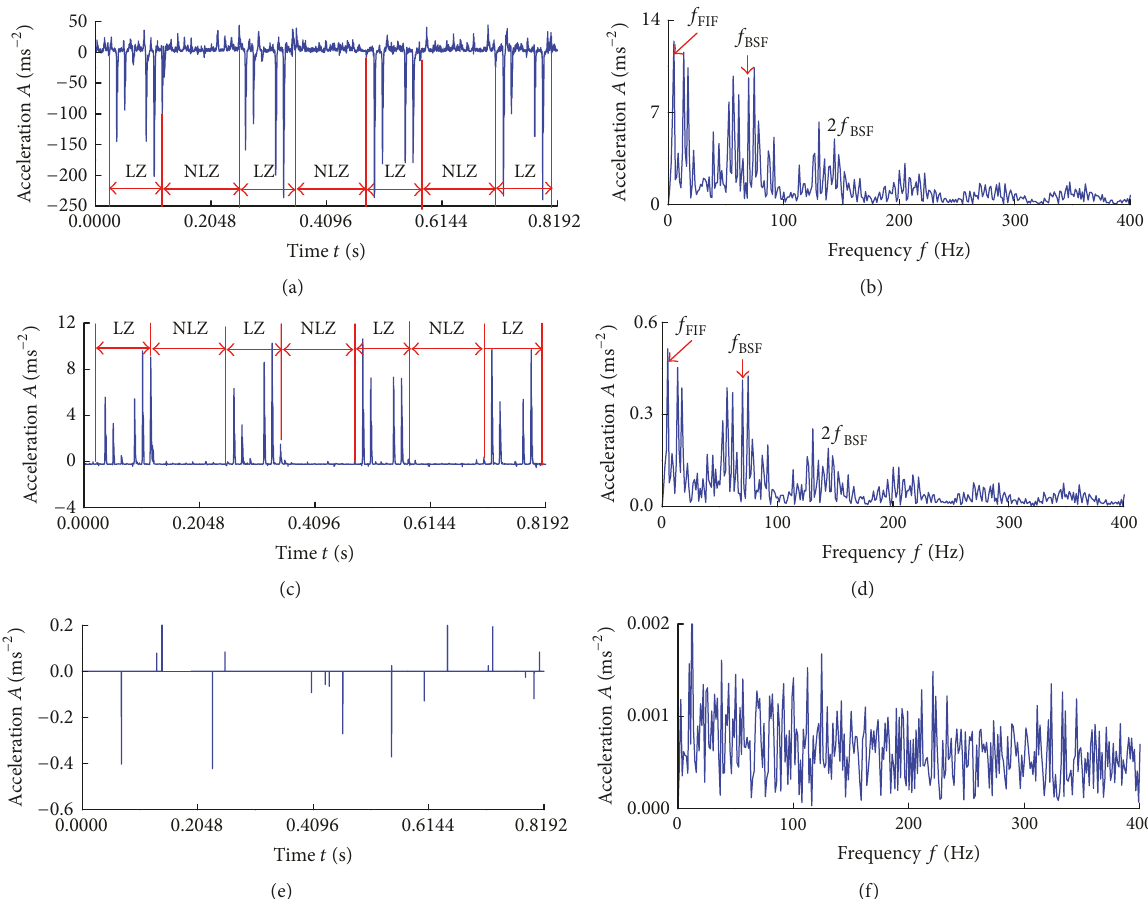
Figure 13: The intrinsic envelopes extracted by the impulse-envelope manifold and their envelope spectra: (a) the impulse-envelope with Isomap, (b) the envelope spectra of (a), (c) the impulse-envelope with LLC, (d) the envelope spectra of (c), (e) the impulse-envelope with LTSA, and (f) the envelope spectra of